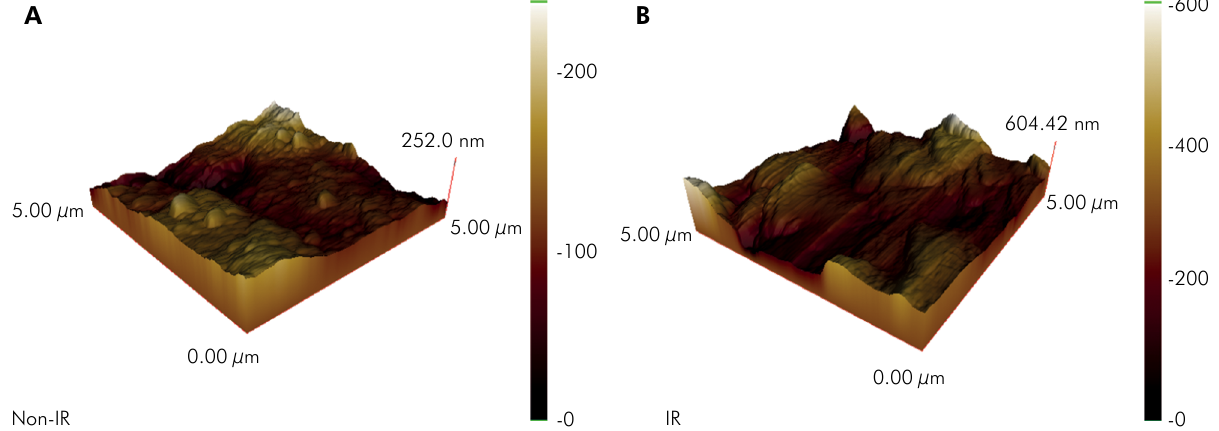
Figure 1. A: AFM image of Amalgomer CR in the Non-IR (non-irradiated) subgroup. The topographical AFM 3D-images were acquired in the contact mode from a 5 × 5 μ m area; B: AFM image of Amalgomer CR in the IR (irradiated) subgroup. The topographical AFM 3D-images were acquired in the contact mode from 5 × 5 μ m